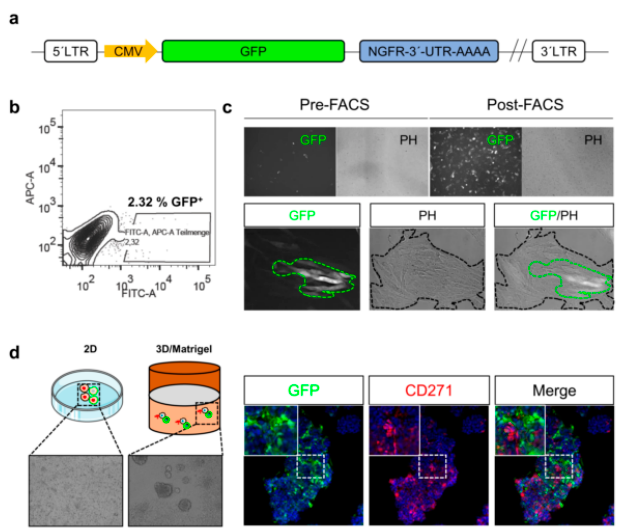
Figure 3. CD271 regulates phenotype switching in melanoma. ( a , b ) A reporter plasmid containing the NGFR/CD271-specific 3 ′ -UTR sequence fused to GFP (green fluorescent protein) enanled theindirect tracing and isolation of NGFR/CD271 expressing melanoma cells. a reporter plasmid ( c ) Cells with a stable integration of the reporter were enriched via FACS (fluorescence activated cell sorting) (upper panels). The absence of GFP indicates the suppression of NGFR transcription or mRNA degradation e.g., via miRNAs. GFP expression was lost over time but maintained in a cellular subset ( c , lower panels). ( d ) GFP + cells participated in the formation of three-dimensional (3D) spheres in matrigel.